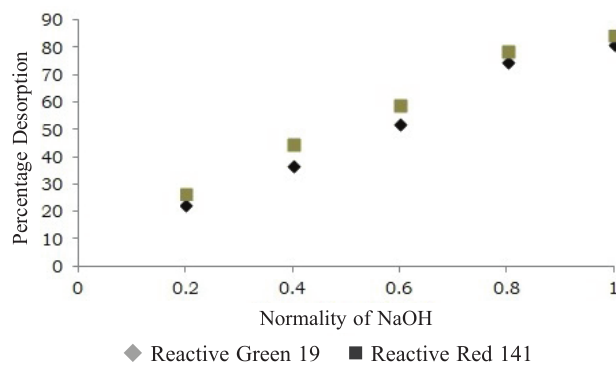
 Reactive Green 19  Reactive Red Fig. 12 – Desorption of reactive dyes from activated carbon